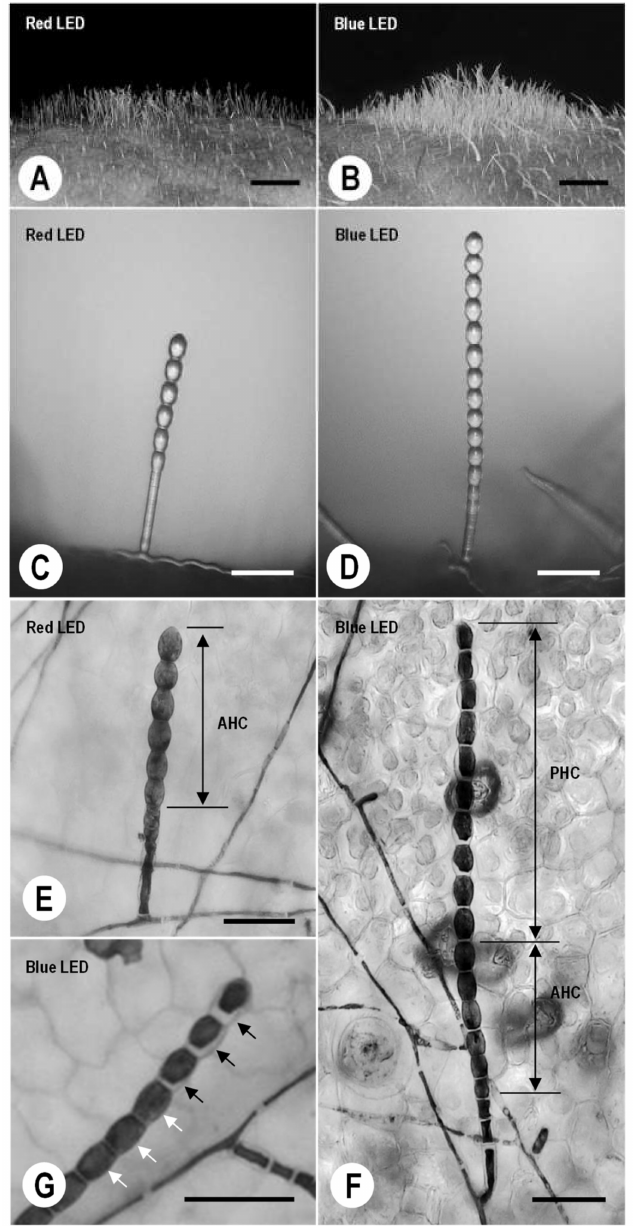
Figure 1. Morphological characteristics of Podosphaera xanthii (Schlechtend.:Fr.) Pollacci KMP-6N colonies and conidiophores on the leaves of melon plants irradiated under red ( A , C , E ) and blue ( B , D , F , G ) light-emitting diodes (LEDs). ( A , B ) Digital micrographs of 12-day-old KMP-6N colonies grown under red LEDs ( A ) were shorter than those grown under blue LEDs ( B ). ( C , D ) Digital micrographs of full-length chains of six ( C ) and 12 concatenated conidia ( D ). ( E – G ) Light micrographs of short ( E ) and long catenated conidia ( F ), and upper parts of long chains of catenated conidia ( G ) observed after histochemical staining. In chains consisting of six or fewer conidial cells, entire conidia were stained (AHC) in ( E ), whereas in chains consisting of more than seven conidial cells, only the central parts of the conidial cells were stained (PHC) in ( F ). In unconstricted conidial cells at the upper parts of conidiophores shown in ( G ), only the central parts of the conidial cells were stained (black arrows), whereas the cells below were entirely stained (white arrows). These micrographs were taken 12 days after inoculation with KMP-6N conidia. Bars represent 500 µ m ( A , B ), and 50 µ m ( C – G